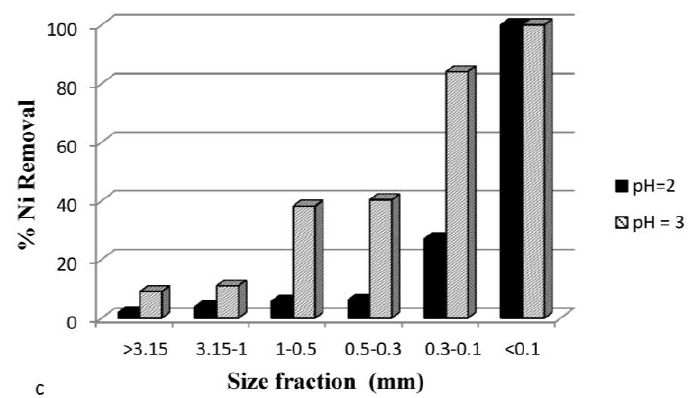
Figure 6. Metal removal by bottom ash as a function of particle size at different initial pH: ( a ) Zn; ( b ) Cd; and ( c ) Ni.